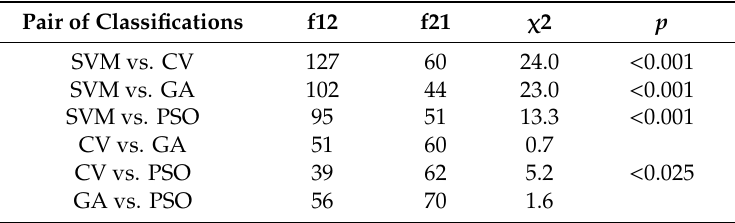
Table 9. McNemar test results of different models for the independent test set. fij: the numbers of cases that were wrongly classified by classifier i but correctly classified by j (i, j = 1, 2); χ 2: chi-square; p : probability value.